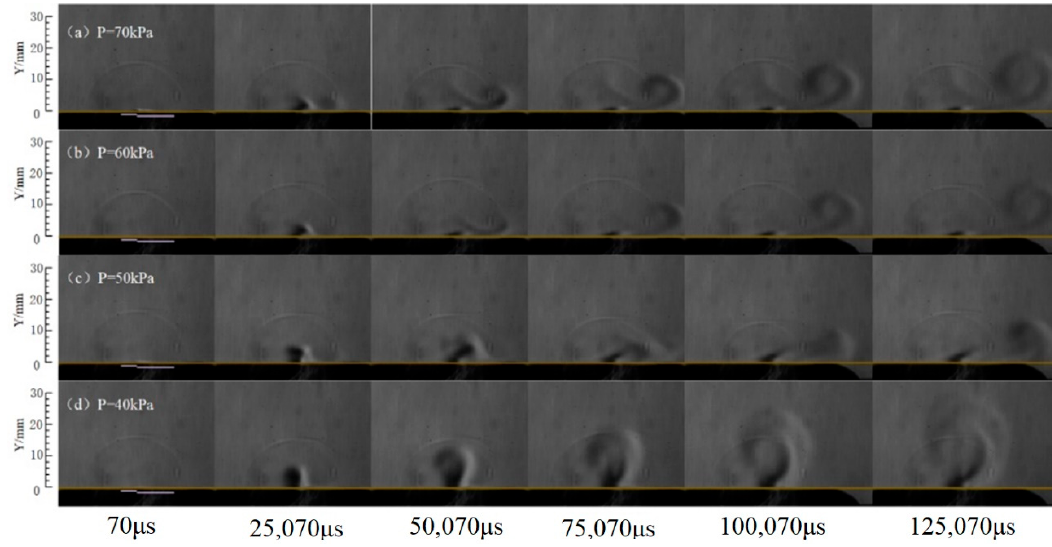
Figure 15. Visualization of the propagating jet flow.